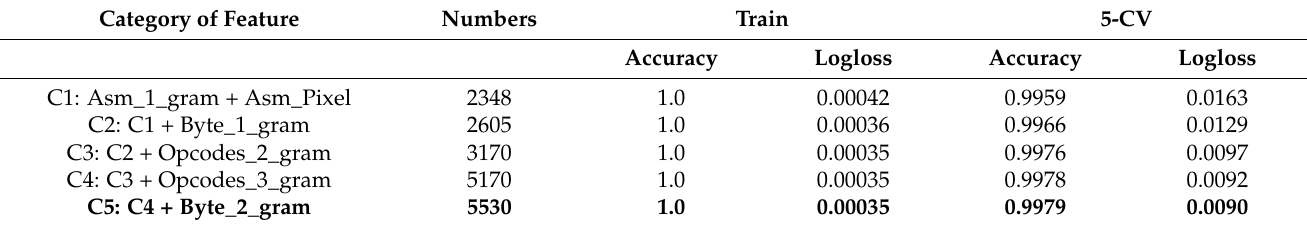
Table 6. Adding features categories gradually based on feature